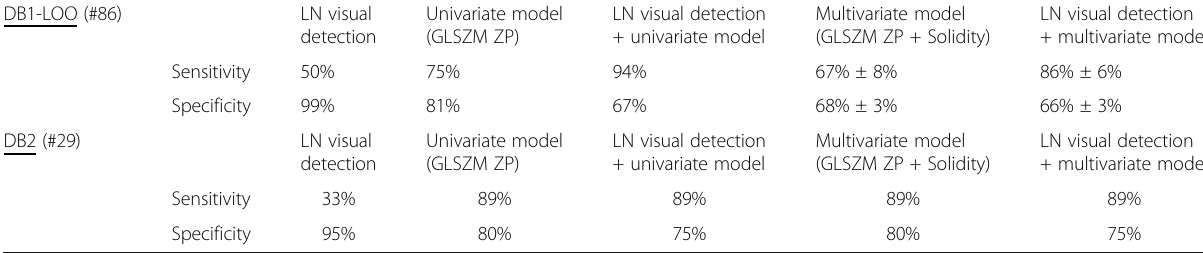
Table 2 Results of univariate and multivariate model testing on DB1 (LOO) and DB2, together with results of nodal status visual assessment and unified prognostic